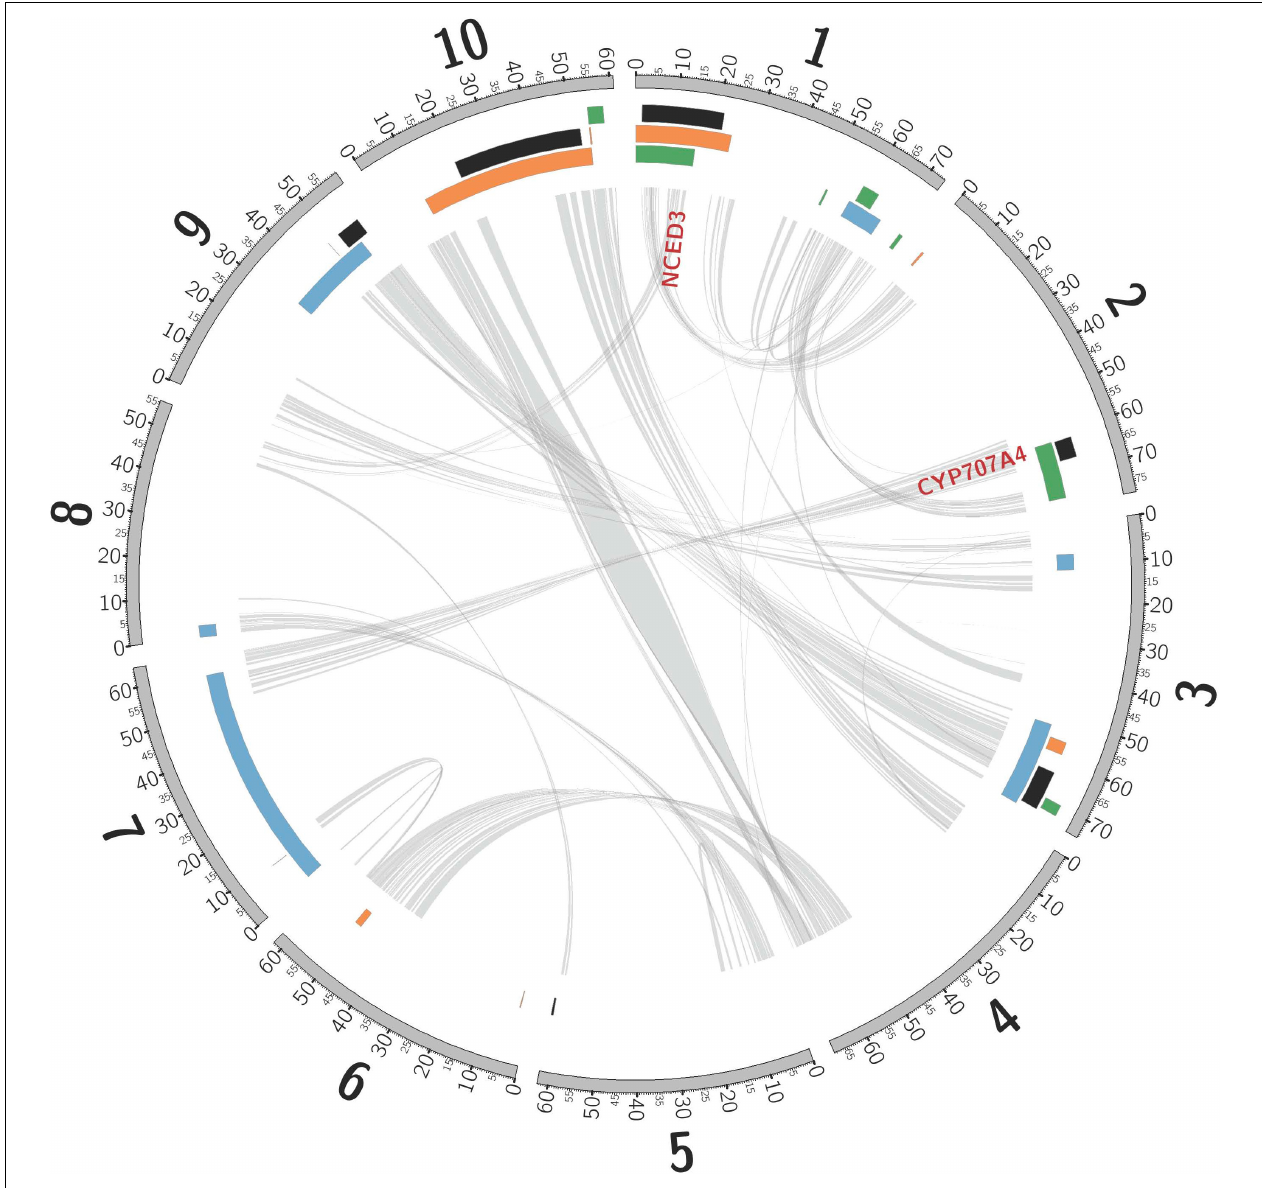
FIGURE 2 | Non-random association between QTLs mapped in sorghum, and introgression from S. bicolor into S. halepense . Sorghum chromosomes (units are megabases), annotated with physical locations of hotspots of introgression from S. bicolor into S. halepense [black (Morrell et al., 2005)] and QTLs for seed lutein concentration [green (Fernandez et al., 2008)], seedling vigor [orange (Fernandez et al., 2008)], and rhizomes [blue (Zhang et al., 2013)]. NCED3 and CYP707A4 are gene candidates for cold tolerance (see text). Internal lines indicate syntenic duplicated genes persisting from whole-genome duplication ∼ 96 million years ago (Paterson et al., 2009; Wang et al.,